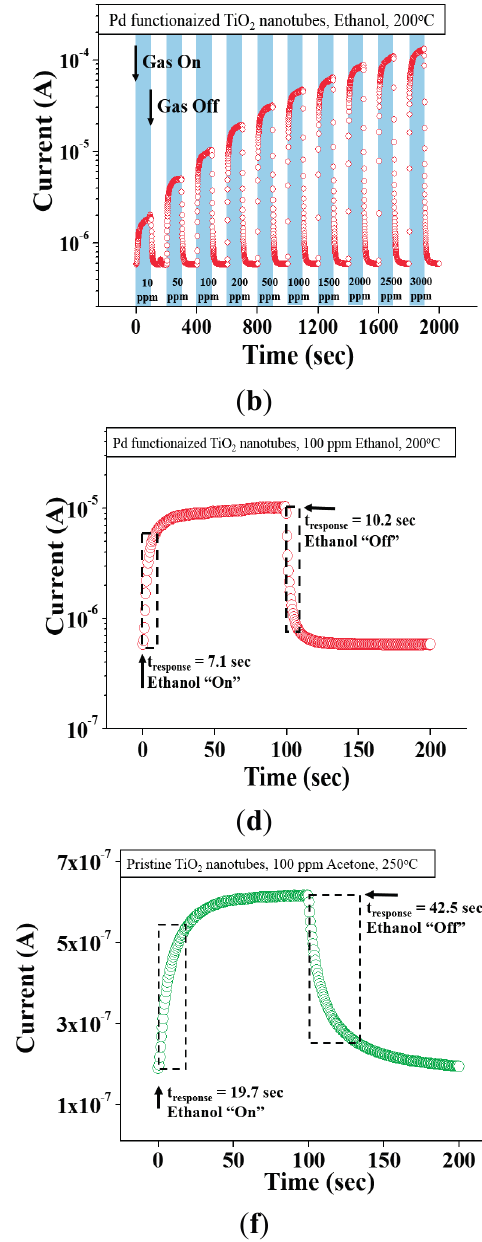
2 H OH gas at 200 °C; 2 5 H OH; 2 5 nanotubes to 100 ppm 2 nanotubes to 2 H OH differs 2 5